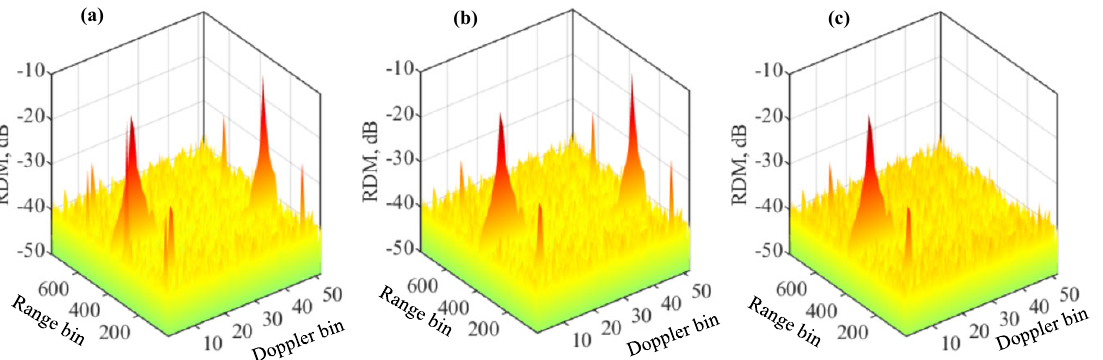
Figure 7. RDMs obtained by Algorithm 4 with four targets simulated. The RDMs from the first three iterations in the algorithms are given in ( a – c ), respectively. Please note that the symbol “-” before all numbers, as automatically generated by MATLAB during plotting the figure, denotes the negative